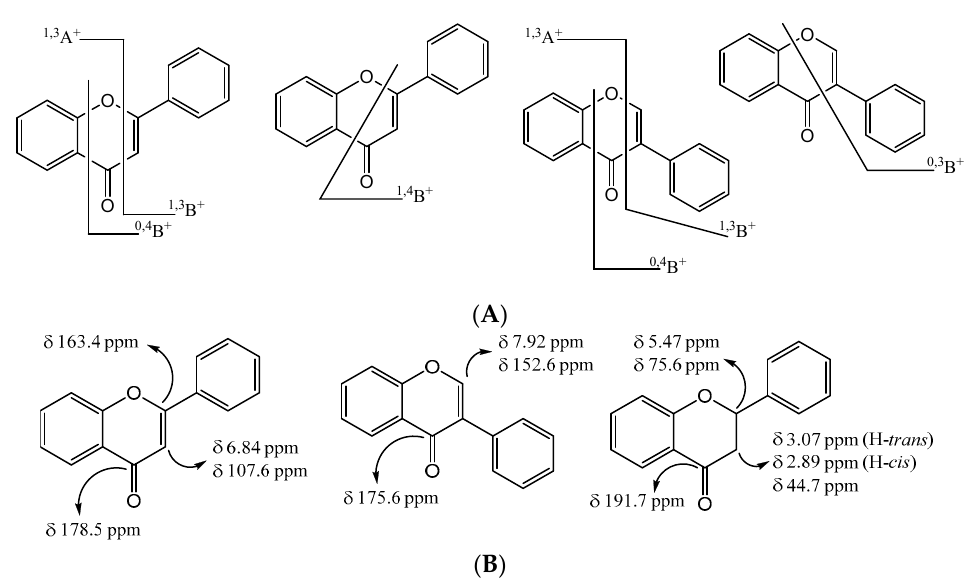
Figure 7. ( A ): The most important ion fragments of flavones and isoflavones. ( B ): The most important NMR signal nucleus.